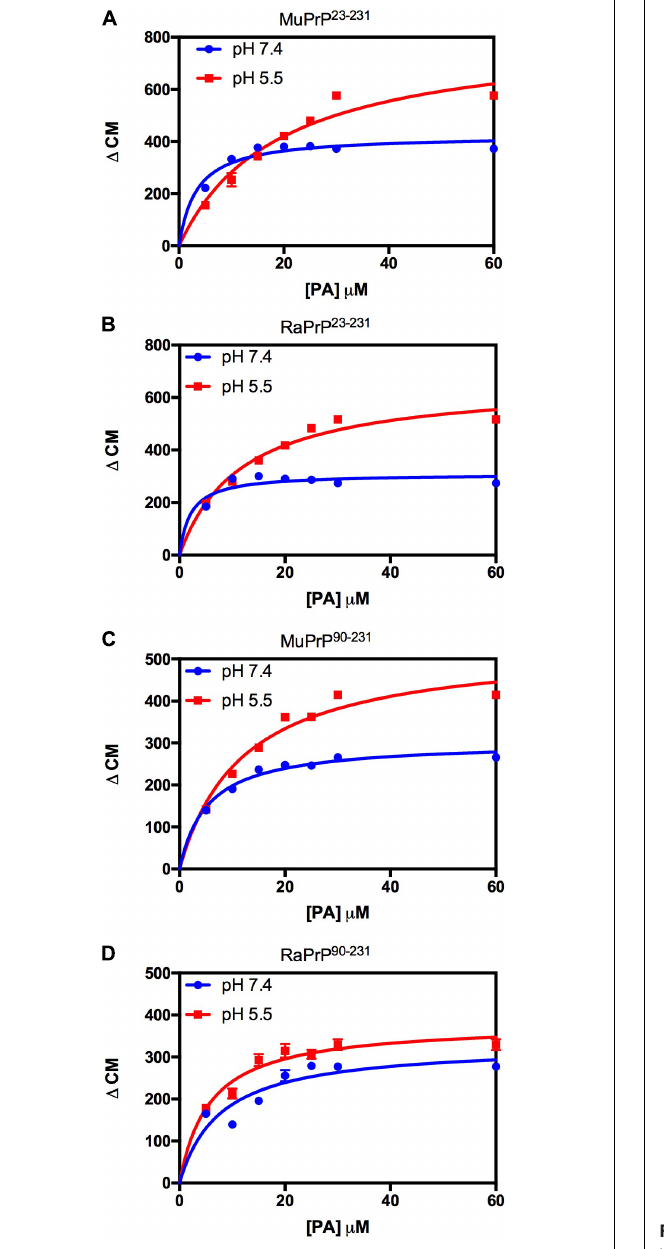
FIGURE 6 | PA-induced structural change is enhanced at acid pH but to a lesser extent for rabbit PrP. Effect of increasing the concentration of PA on the center of mass values obtained from the fluorescence spectra of MuPrP 23 − 231 (A) , RaPrP 23 − 231 (B) , MuPrP 90 − 231 (C) , and RaPrP 90 − 231 (D) at pH 5.5 (red) and 7.4 (blue). All proteins were analyzed at 2 µ M. The experiments were performed in 50 mM Tris buffer containing 100 mM NaCl at pH 7.4 or in 20 mM sodium acetate buffer containing 100 mM NaCl at pH 5.5. All experiments were performed at 25 ◦ C. The error bars represent the standard deviation of at least two independent experiments.